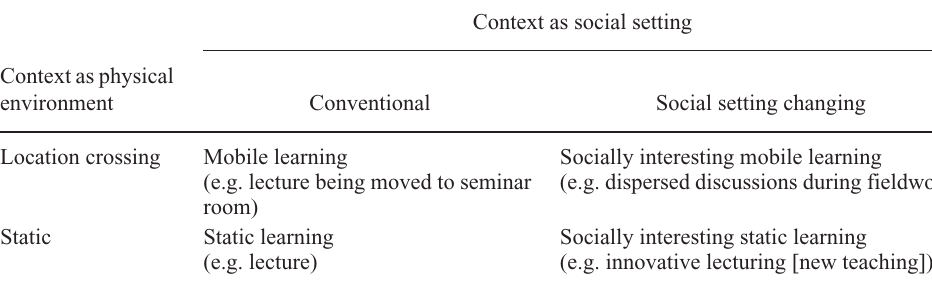
Table 3. Illustration of context crossing as a basis for defining mobile and static